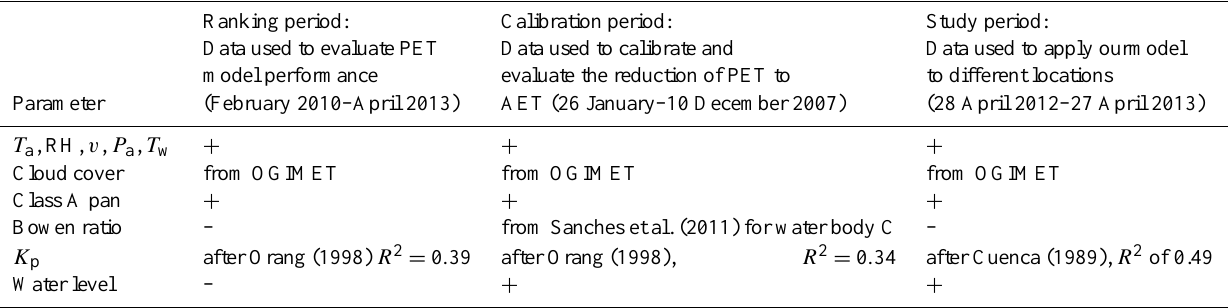
Table 3. Data availability ( + = available, – = not available or reference to data source). Ranking period: Calibration period: Study period: Data used to evaluate PET Data used to calibrate and Data used to apply ourmodel model performance evaluate the reduction of PET to to different